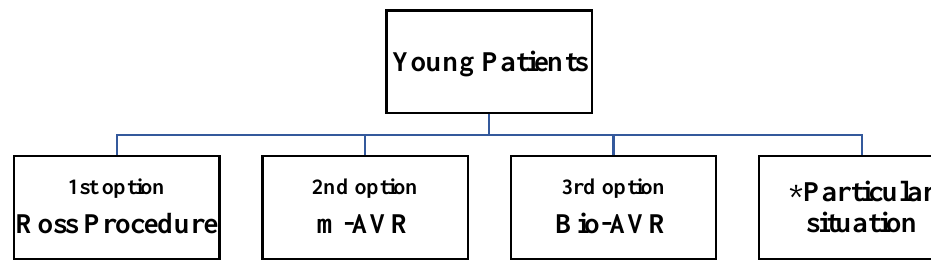
Figure 1. Priority of aortic valve substitutes for young patients. Table 1. Decision Making Algorithm. Ross Procedure for young patients.